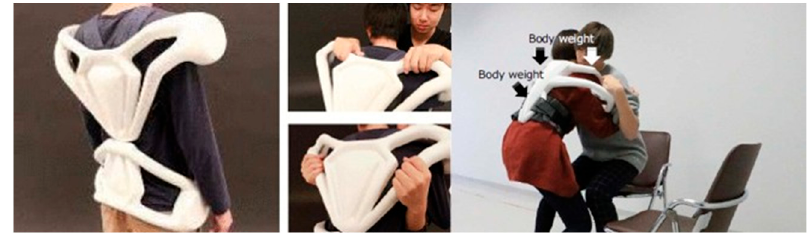
Figure 2. Hydraulic Exoskeleton for carers involved in assistance and transfer for bathing patients [54]. Reprinted with permission from author